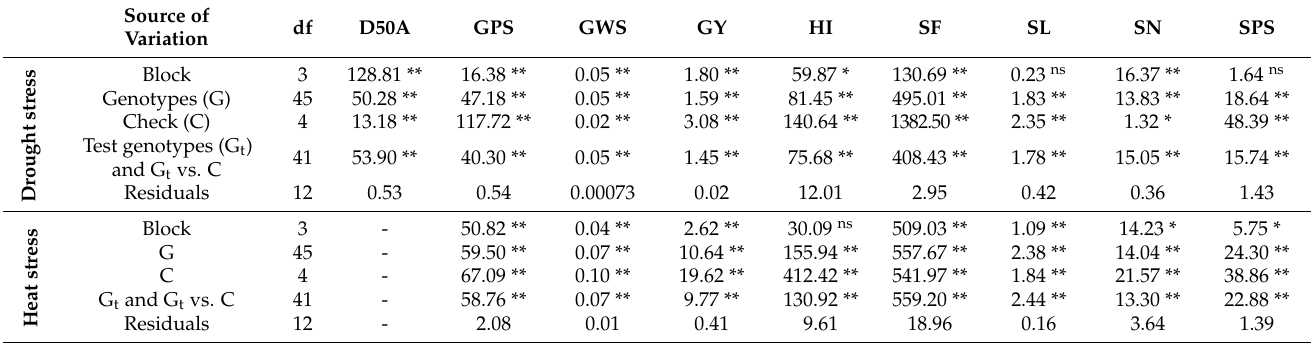
Table 2. Analysis of variance for grain yield and yield components of the 46 wheat genotypes grown under drought and heat-stressed environments. Mean square values and significance tests at 5% significance level for related traits are shown below.